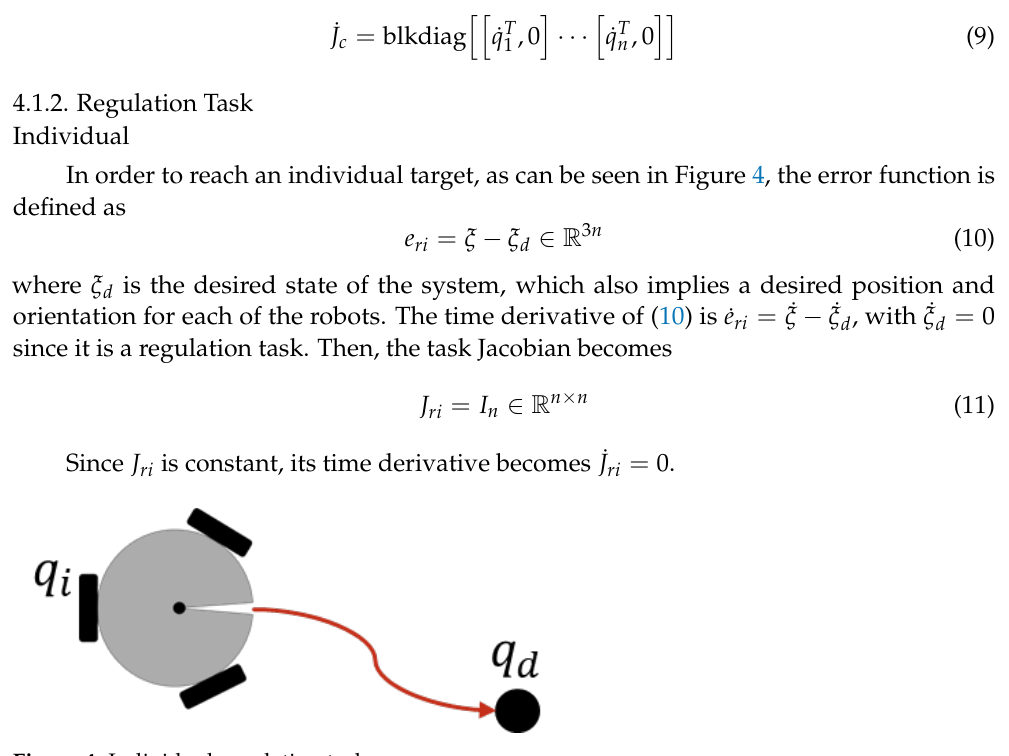
Figure 4. Individual regulation task.